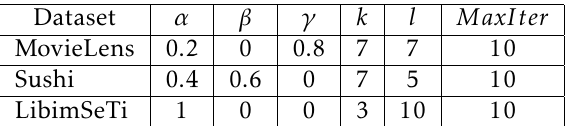
Table 2. Parameter setup for kMeans-NMF